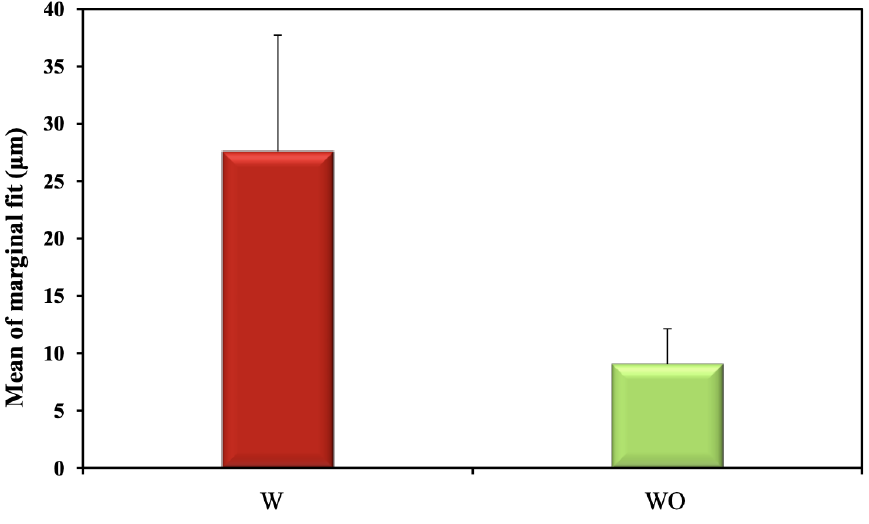
Figure 9. Comparison between marginal fit ( μ m) of two studied preparation